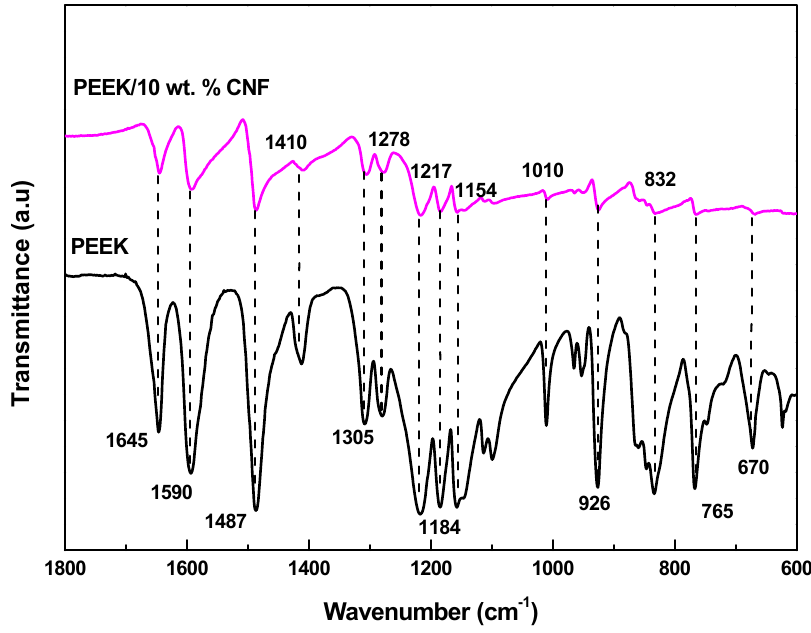
Figure 4. FTIR of PEEK and PEEK/10 wt.% CNF composites (short dot lines are to guide the eyes).